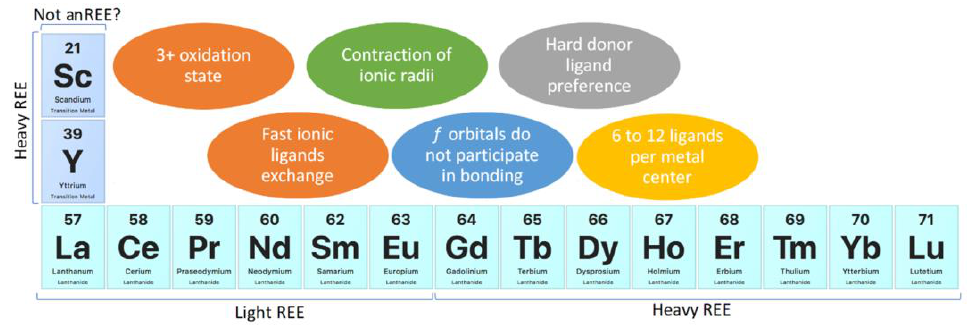
Figure 2. REE chemistry highlights .